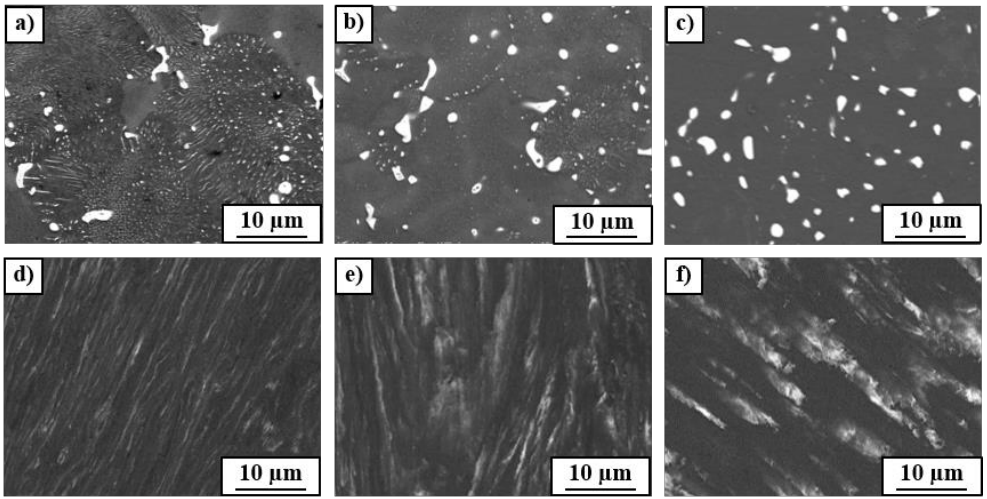
Figure 2. SEM images of the Cu–8wt.%Ag alloy after annealing at ( a ) 400 °C; ( b ) 500 °C; ( c ) 600 °C and after HPT deformation: ( d ) 400 ◦ C + HPT; ( e ) 500 ◦ C + HPT; ( f ) 600 ◦ C + HPT.